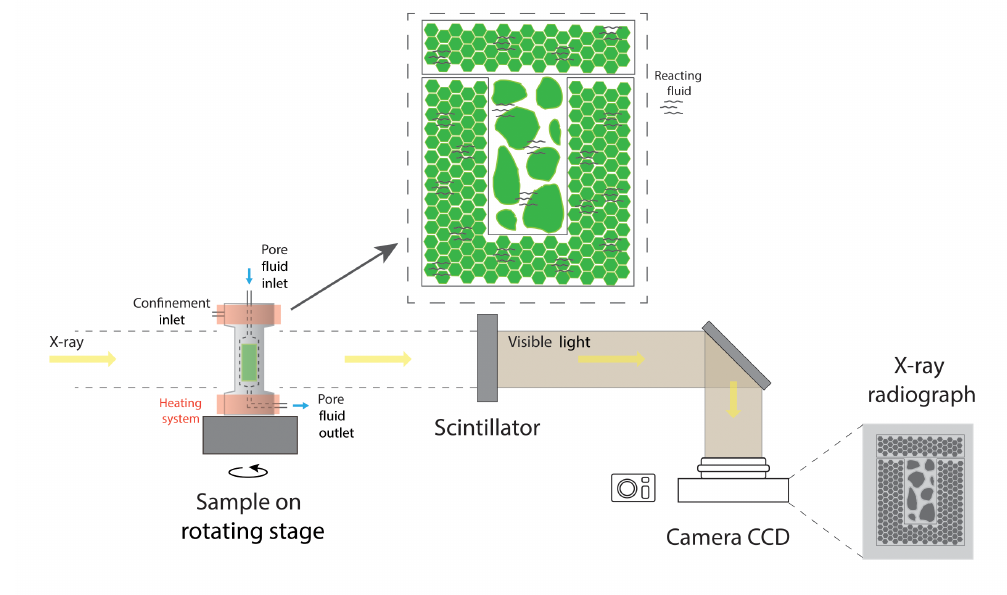
Figure 3. Experimental setup for dynamic microtomography. Inside the X-ray transparent pressure cell, the confining pressure, pore pressure and temperature can be controlled independently. The synchrotron radiation imaging records radiographs of the sample at in situ conditions with ongoing reaction at different angular positions with the sample being